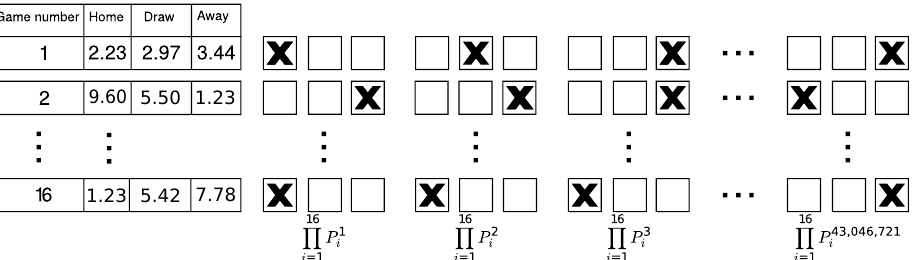
Figure 2. Schematic view of the form ranking algorithm. The table on the left shows the final odds for each game in an example round. The odds are the return for investing 1 dollar. The panels to the right of the table illustrate the ranked forms that are filled according to the strategy. The left-most form is ranked 1st as it has the highest probability to win the big prize, and the right-most form is ranked 43,046,721 as it has the lowest probability to win the big prize.